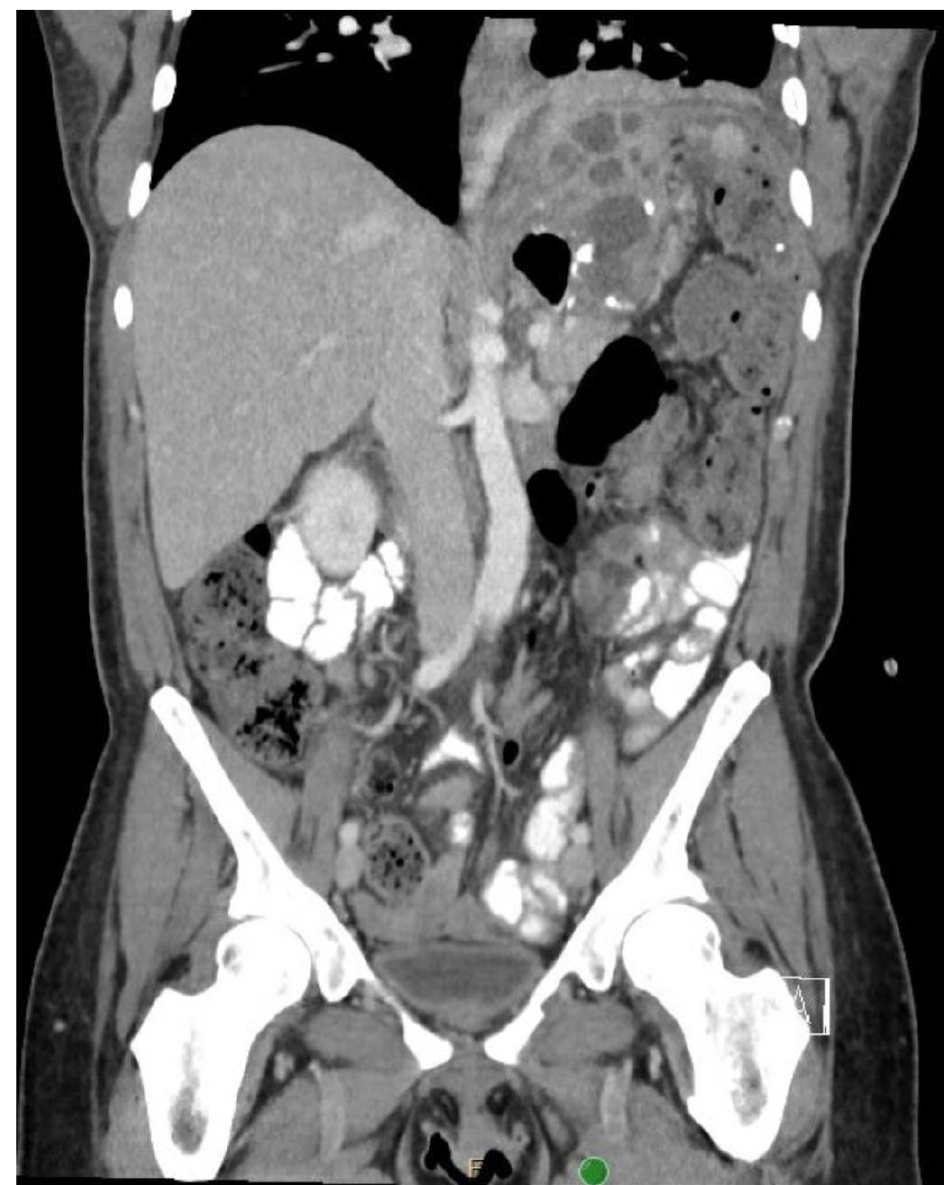
Figure 3. CT showing multiloculated abscess and suspected orphaned stomach segment.